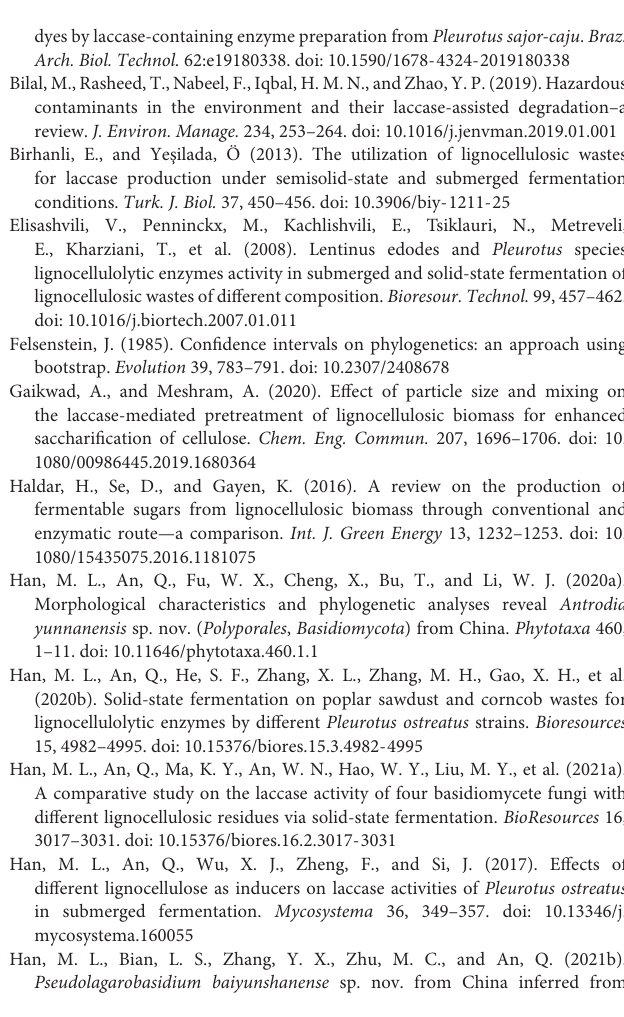
mixture by Pinus tabuliformis and Firmiana platanifolia